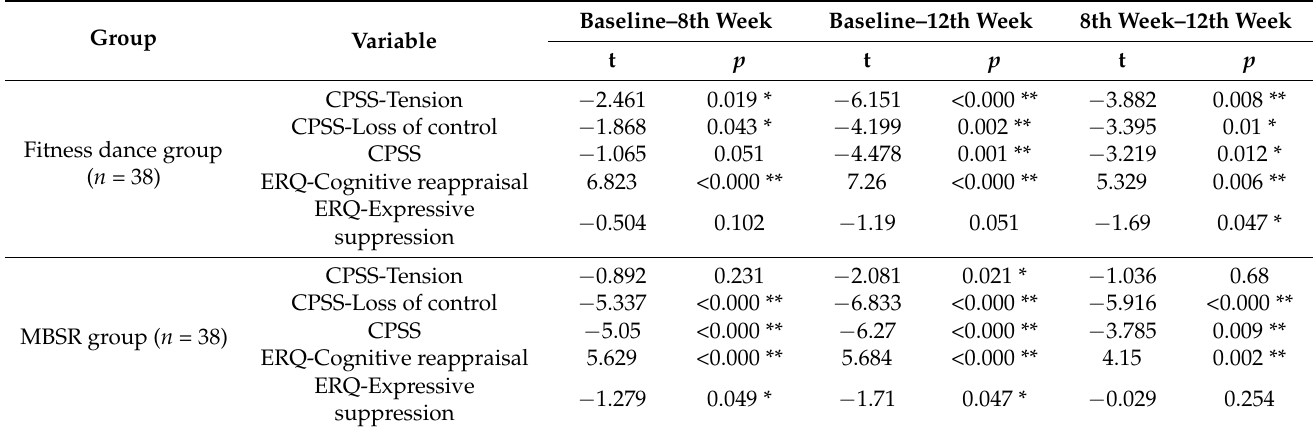
Table 5. Comparison of perceived stress and emotion regulation between the two groups at the 8th and 12th